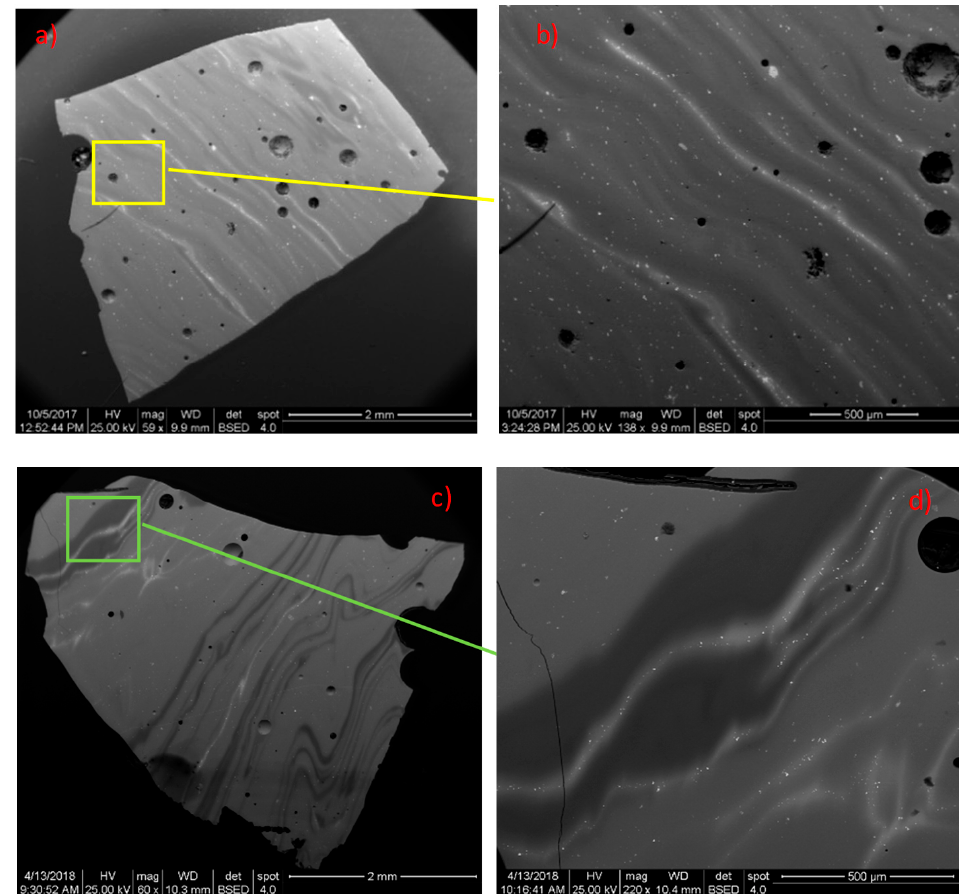
Figure 27. BSE images of the micro-texture of the vitreous matrices of yellow ( a , b ) and green ( c , d ) glasses. Highly non-homogeneous micro-textures could be observed, with lighter bands of higher average atomic number detectable in BSE (DMS_2Bb yellow natron-based Egypt I glass tessera and DMS_1Ab green natron-based Egypt I glass tessera from the Great Mosque of Damascus, Syria—unpublished data [24,25]).